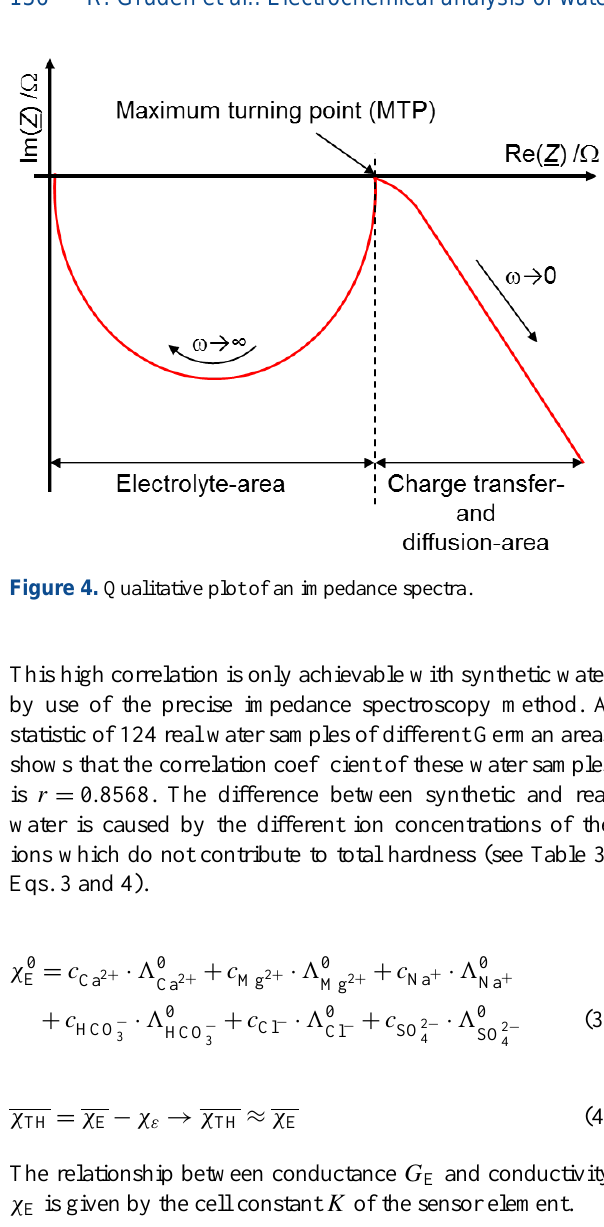
Figure 8. Current response as a function of carbonate hardness.